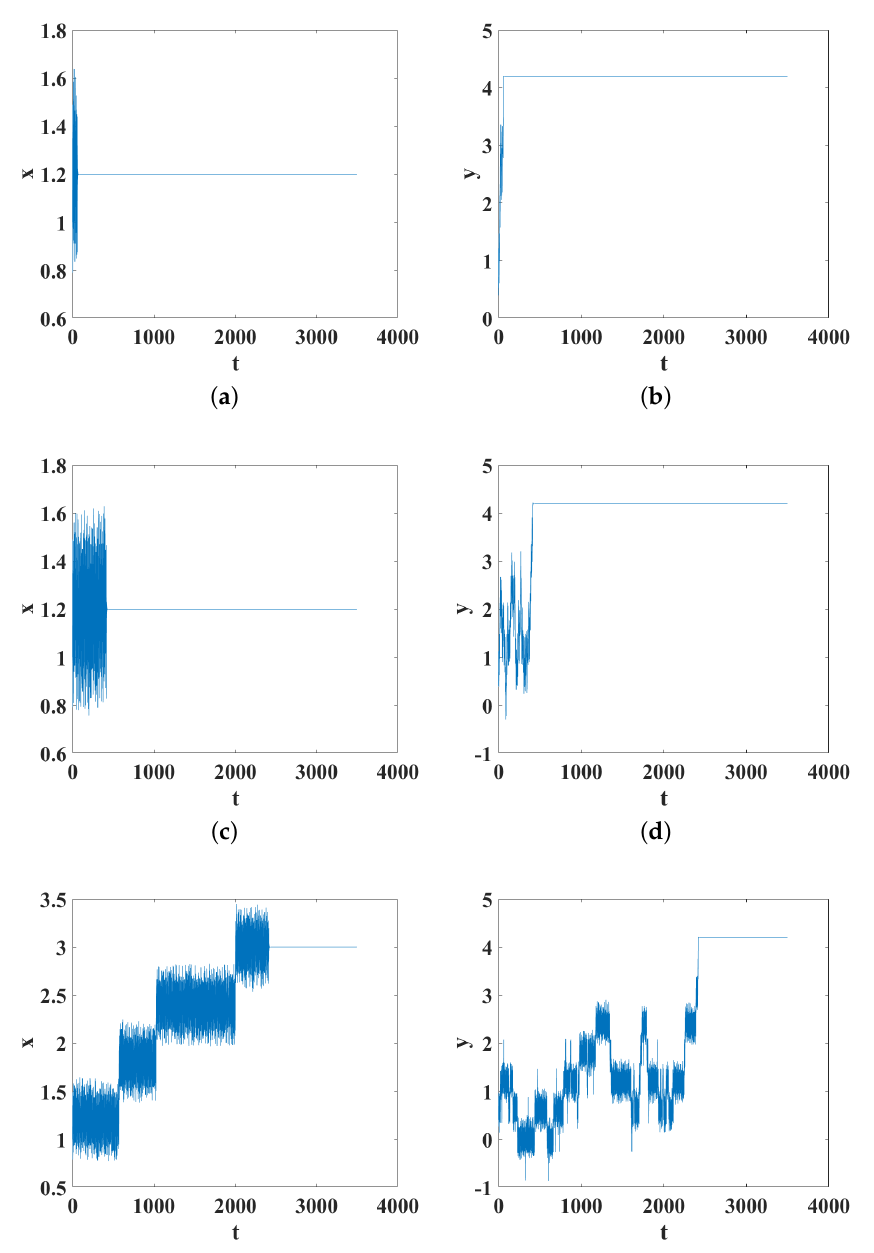
Figure 1. Times of particle settling for different initial conditions and a single value of the dispersion medium ( m = 6). ( a , b ) k 2 = 0.6; ( c , d ) k 2 = 0.7; ( e , f ) k 2 =